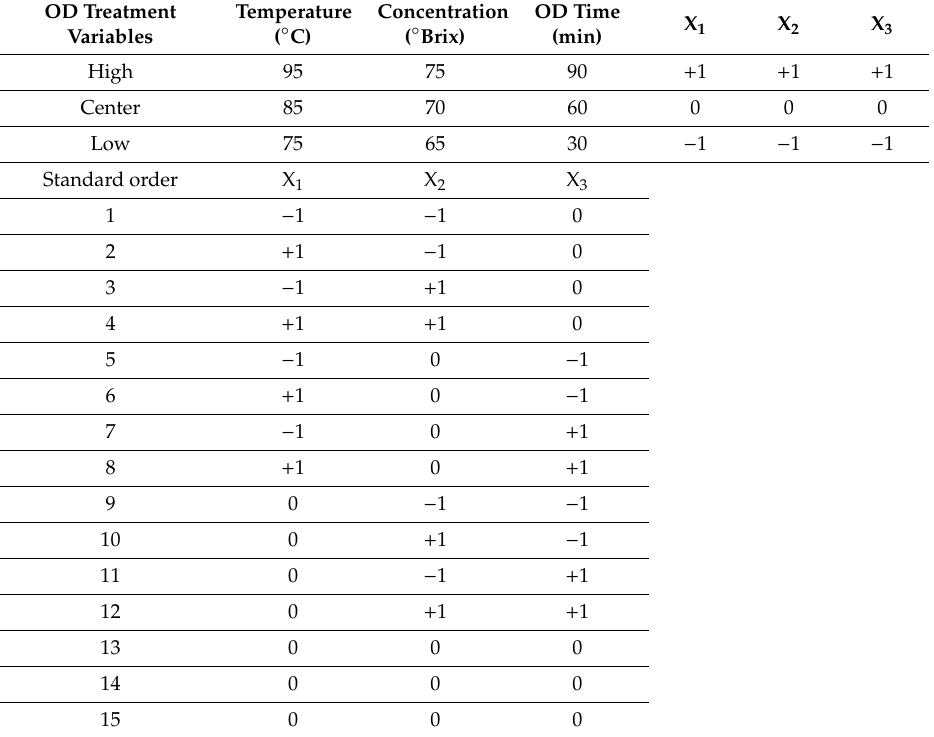
Coded values of the treatment variables for all types of osmotic solutes used and Box–Behnken